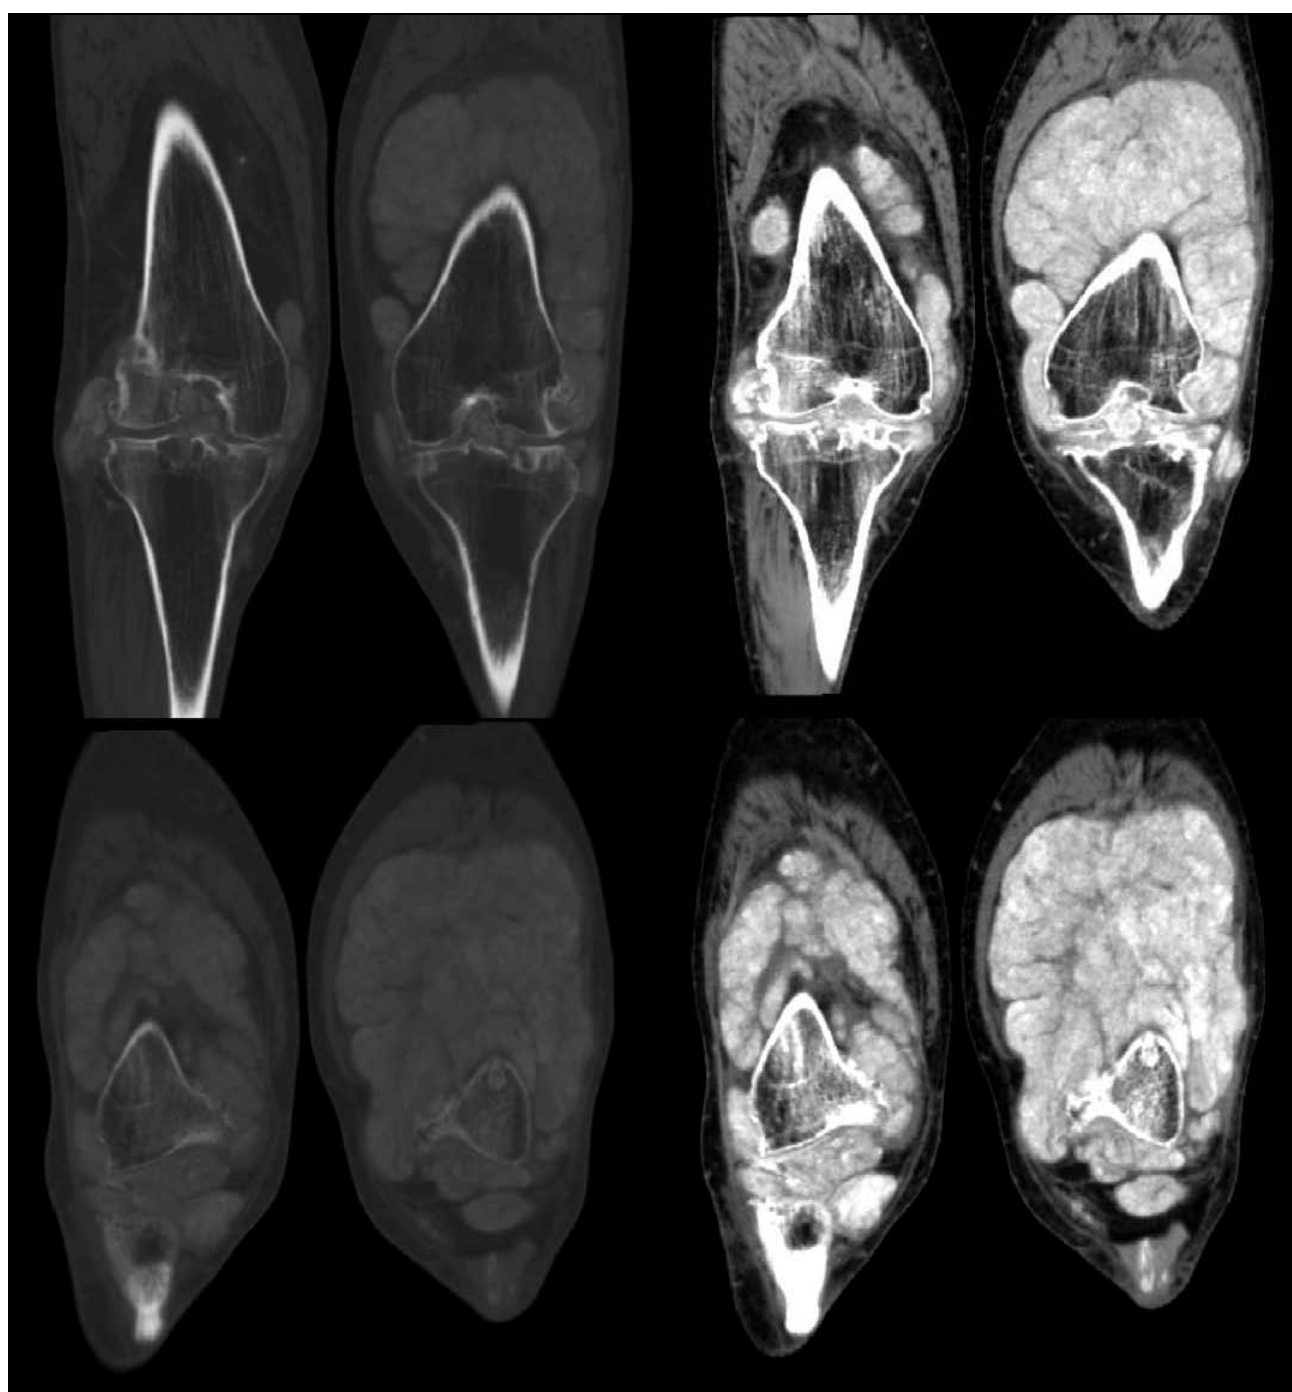
Fig. 5. Coronal non-enhanced CT images of the patient’s knees show diffuse lobulated hyperdense synovial tophaceous deposits measuring 160 - 175 Hounsfield